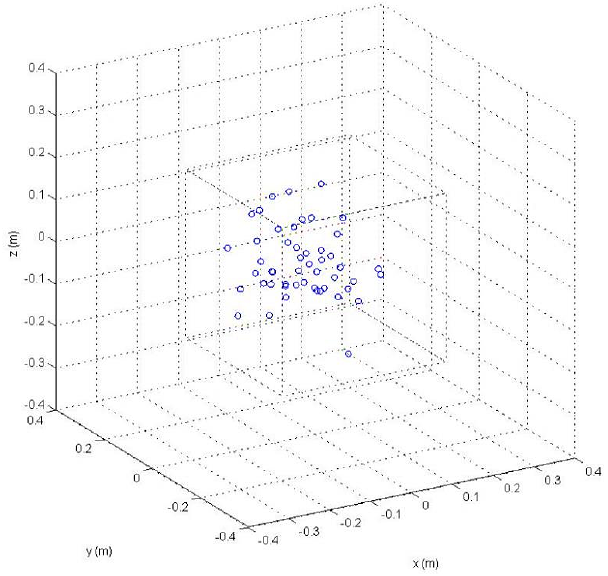
Figure 1. EUT consisting of multiple magnetic sources. Table 1. Parameters of the magnetic